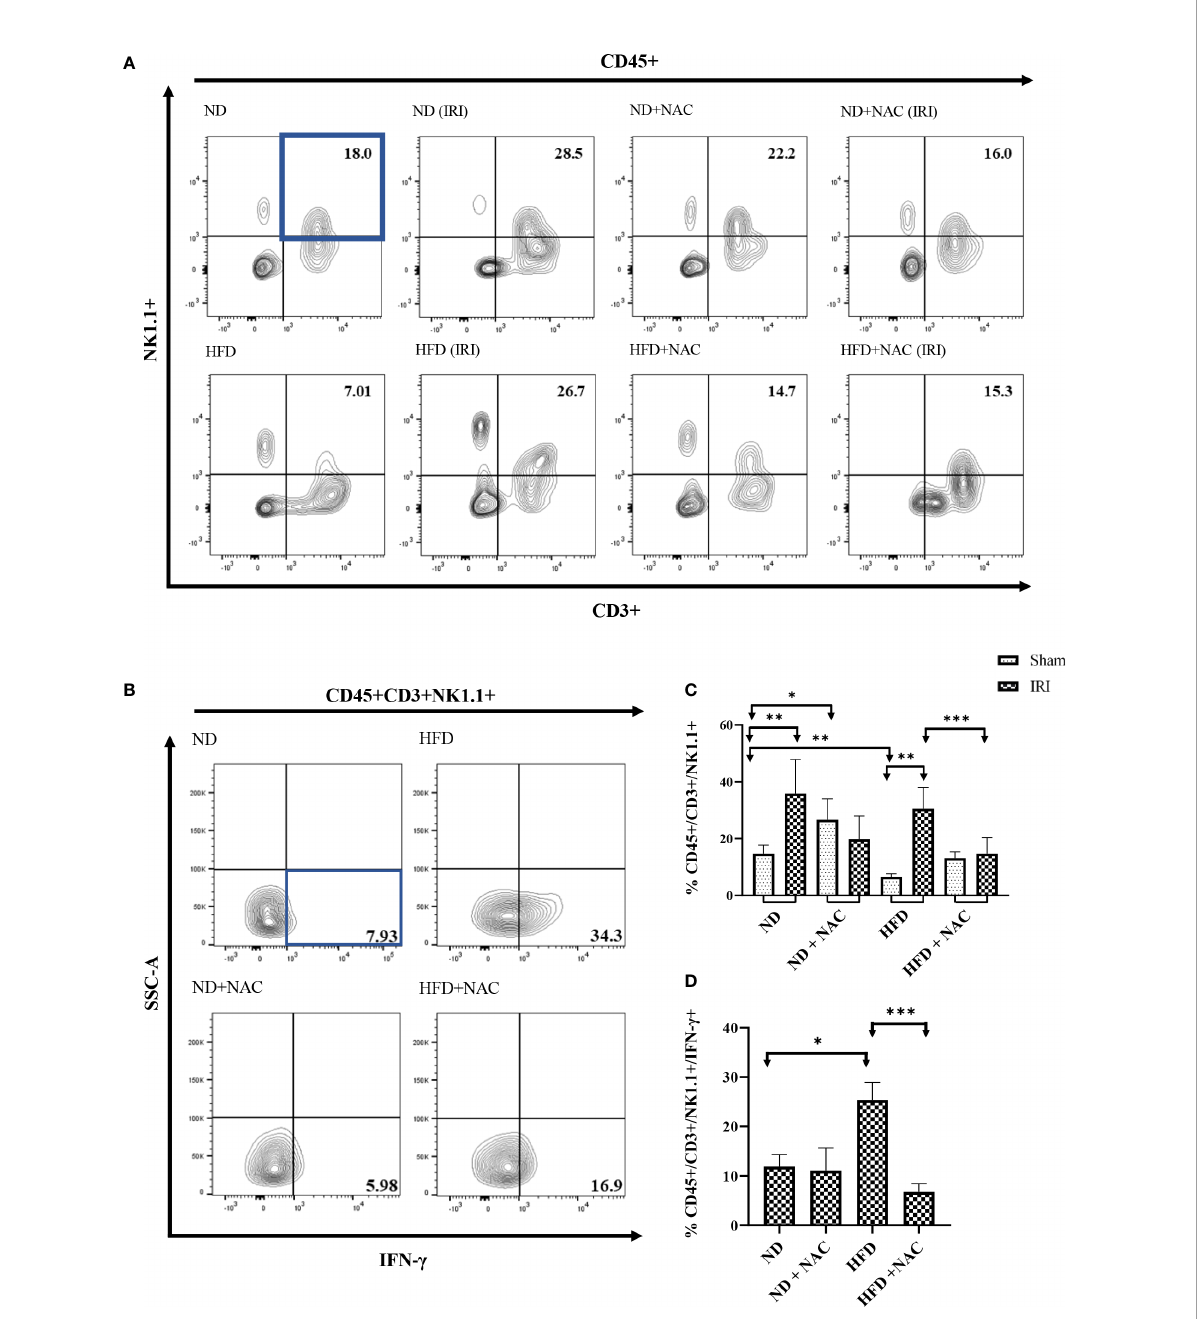
FIGURE 7 IFN- g producing Hepatic CD3+/NK1.1+ cells are contributors following IRI and successfully ameliorated with NAC supplementation. (A) Representative contour plots of the percentage of CD45+/CD3+/NK1.1+ NKT1 cells within Hepatic Mononuclear cells. Number of mice per group is as follows: ND=6, ND (IRI)=5, ND + NAC= 5, ND + NAC (IRI)=11, HFD=5, HFD (IRI)=5, HFD + NAC=5, HFD + NAC (IRI)=10. (B) Representative contour plots of the percentage of IFN- g producing CD45+/CD3+/NK1.1+ NKT cells after IRI. Number of mice per group is as follows: ND (IRI)=5, ND + NAC (IRI)=5, HFD (IRI)=7, HFD + NAC (IRI)=10. (C) Histogram demonstrating the percentage of NKT1 cells illustrated in (A) . (D) Histogram demonstrating the percentage of NKT1 cells illustrated in (B) . “ * ” 0.05 to 0.01, “ ** ” 0.01 to 0.001, “ *** ” 0.001 to